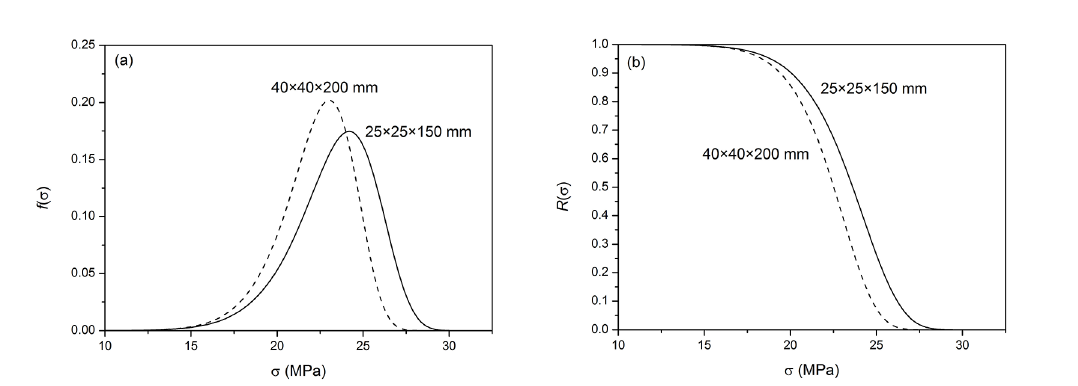
Figure 4. Relationship of strength and (a) probability density function and (b) reliability for high alumina bricks